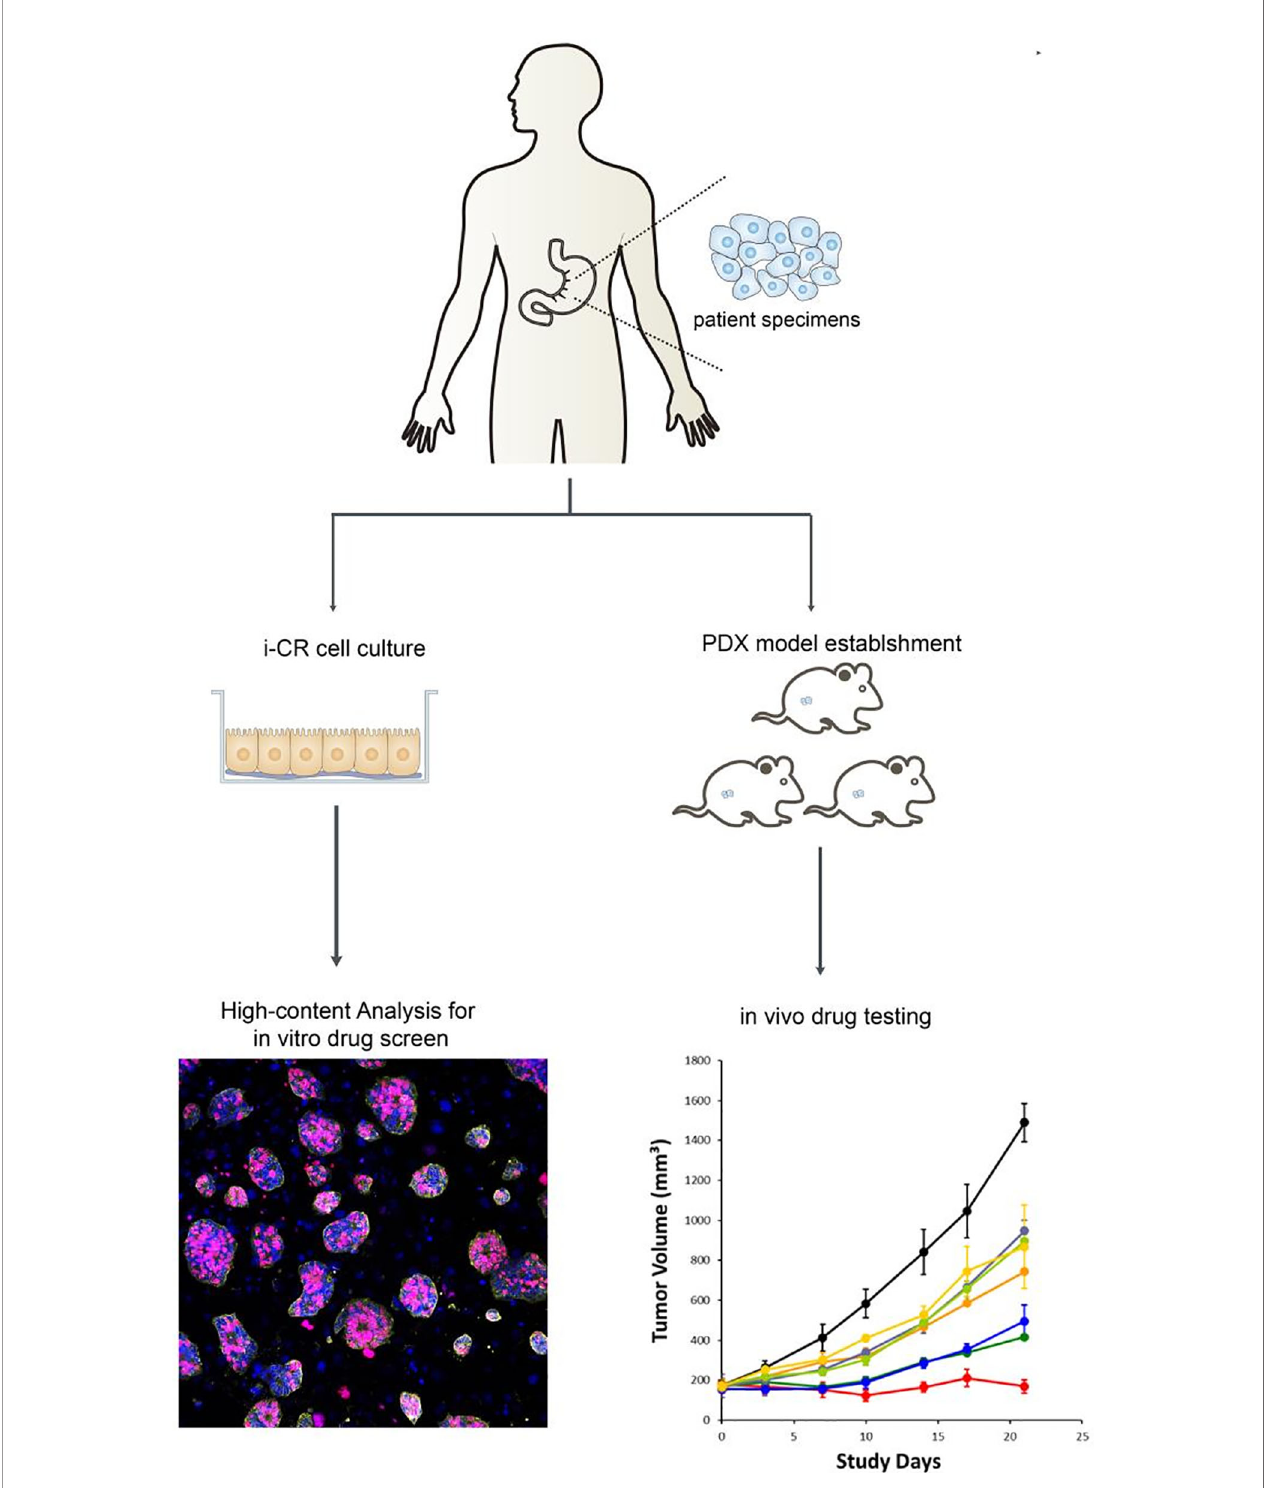
FIGURE 2 | In vitro culture and drug sensitivity screening process of GC cells using the i-CR system and PDX